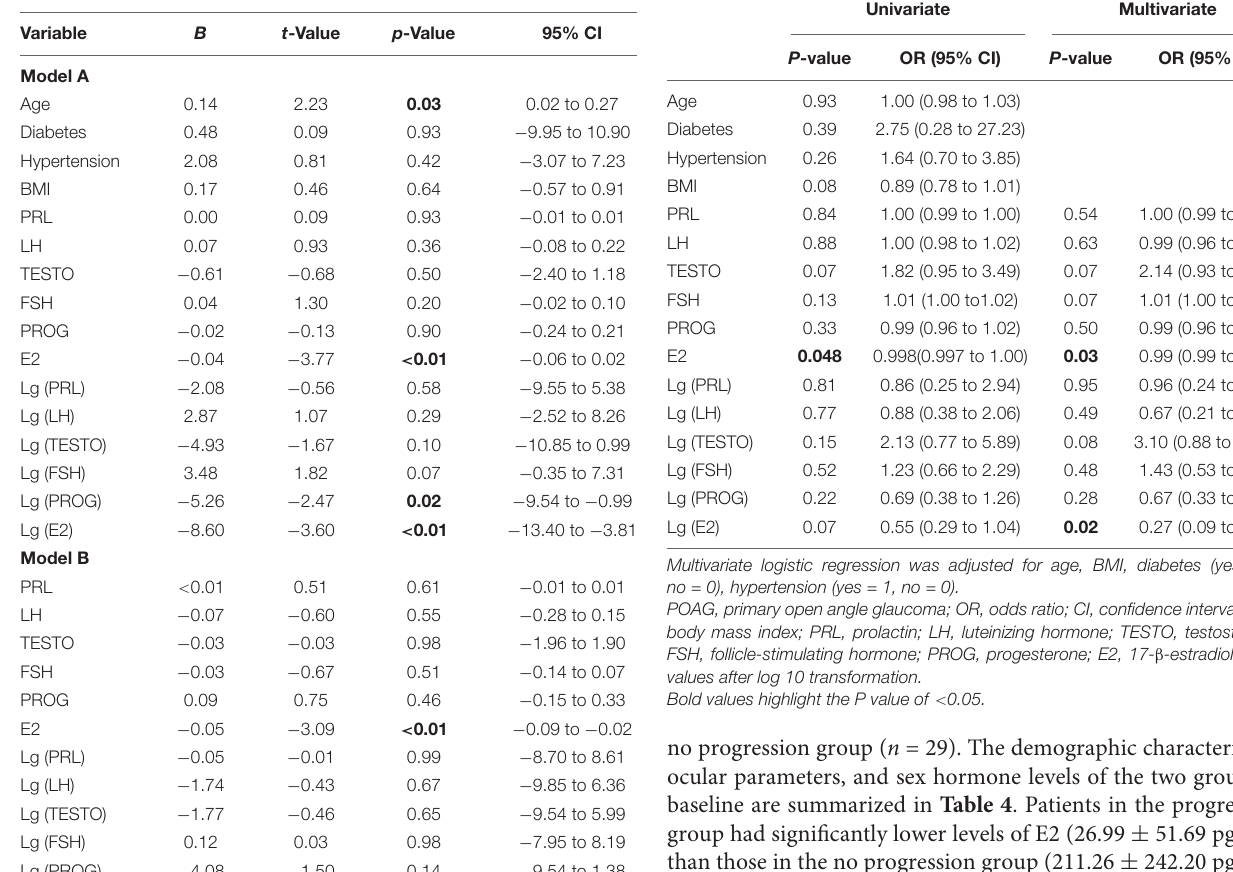
TABLE 2 | Univariate linear regressions and multiple linear regressions for associations between characteristics and blood sex hormone level with visual field mean deviation and in women with POAG.